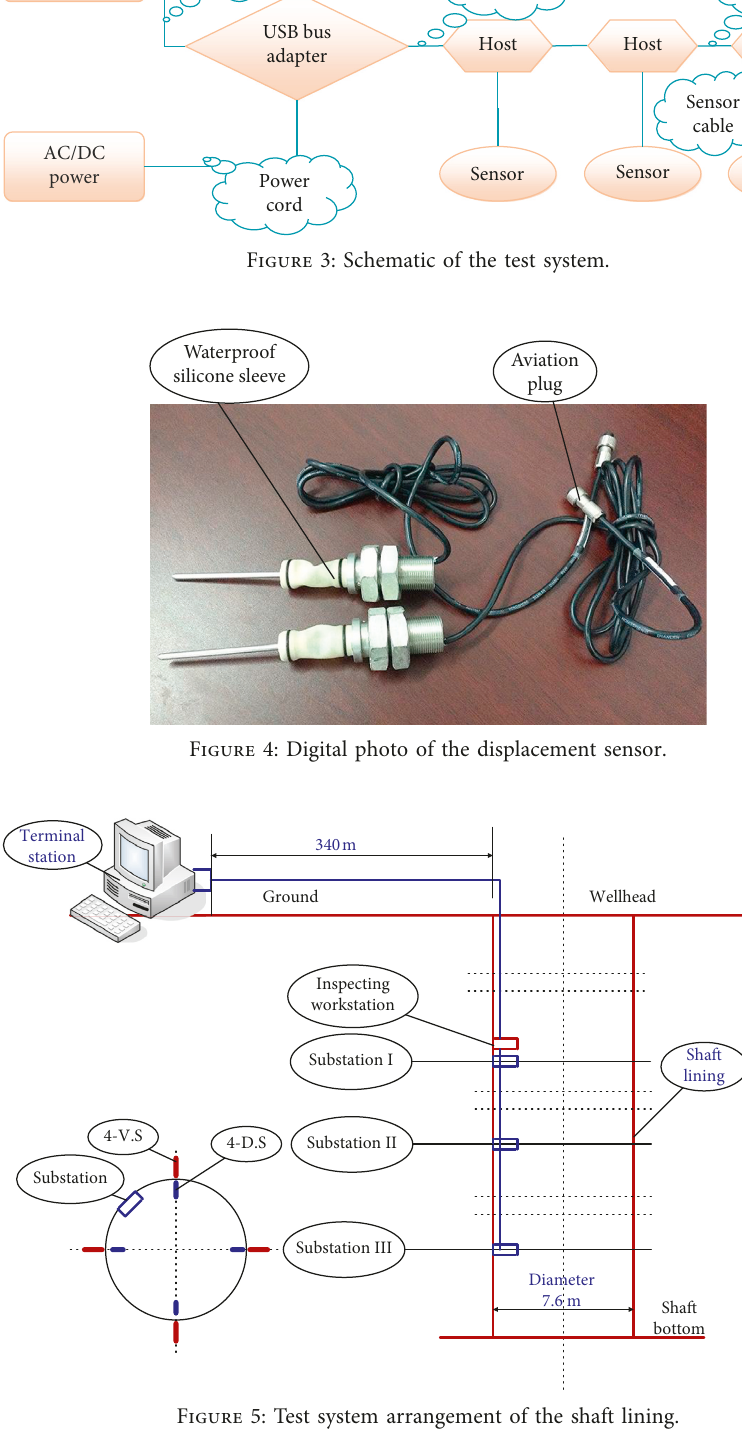
Figure 5: Test system arrangement of the shaft